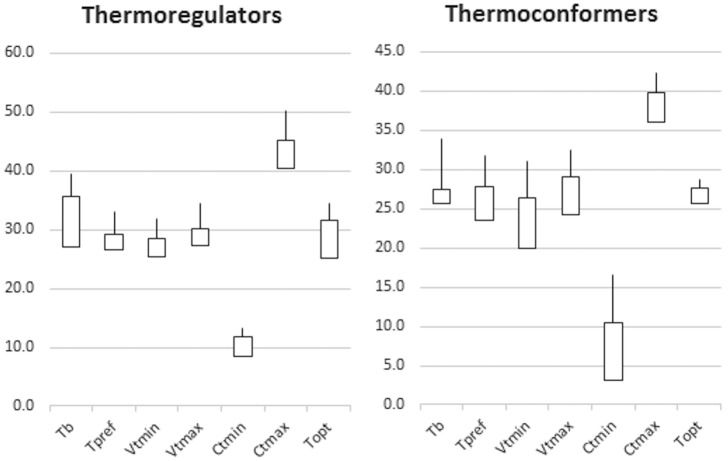
Range of evaluated thermal traits.Species were classified a priori as thermoregulator or thermoconformers. Lines indicate the maximum values.